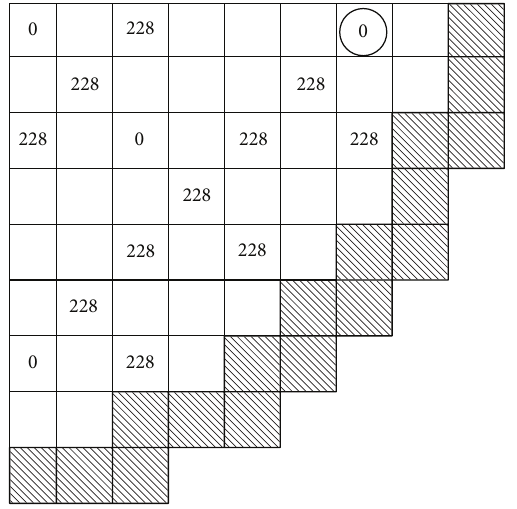
Figure 4: The initial control rod positions for case B1 (circled position is ejected).